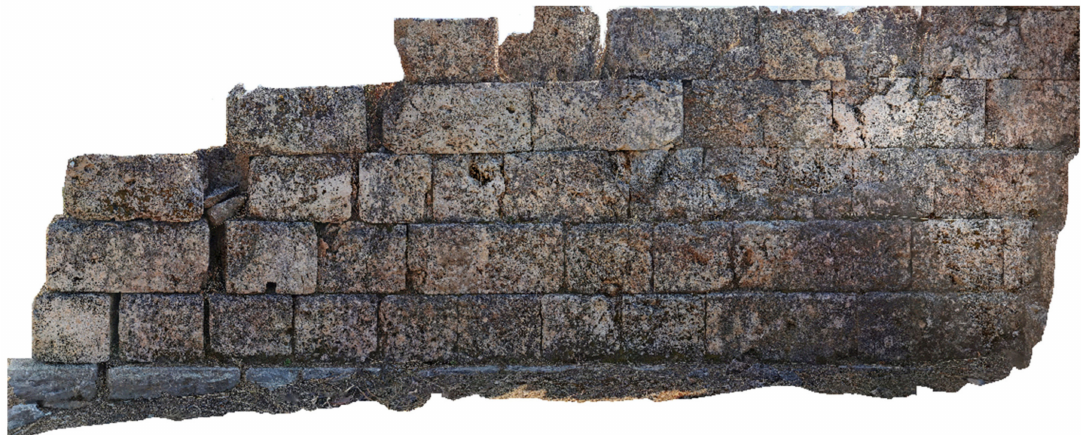
Figure 19. Orthomosaic of an ancient wall at the archaeological site of Lepreum.